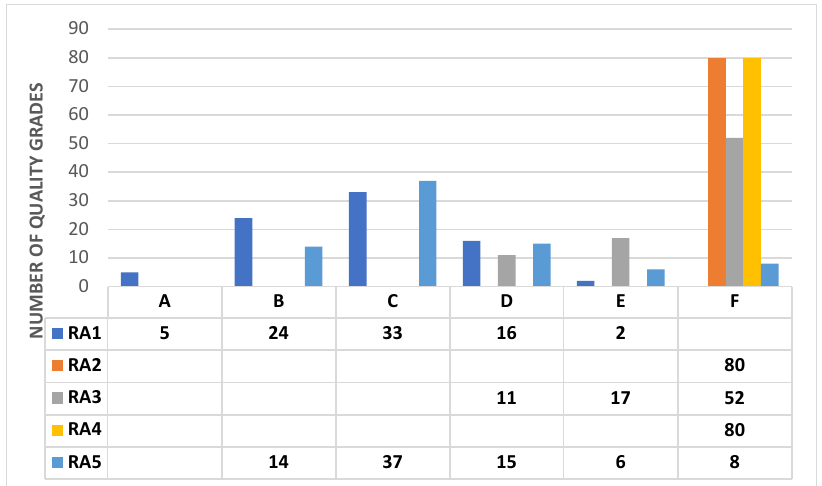
Figure 3. Quality scores or grades for different review areas. Key/Legend: RA1=Descriptions; RA2=Terrain susceptibility; RA3=Impact predictions; RA4=Mitigation/Alternatives; RA5=Commu- nication of results.